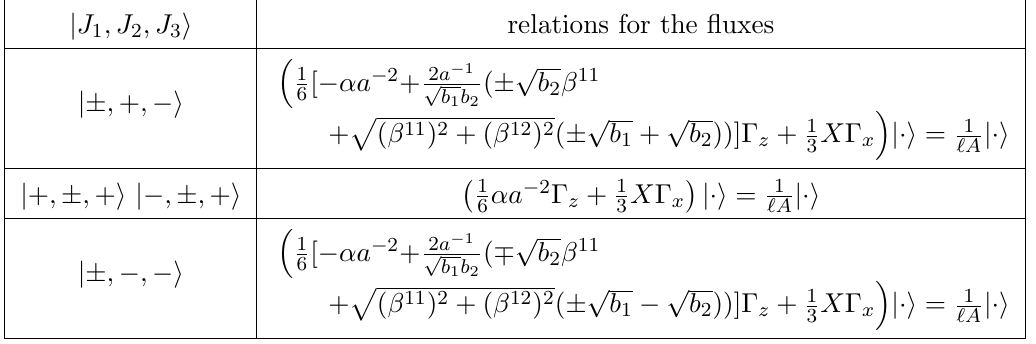
Table 10 . Decomposition of (4.92) KSE into